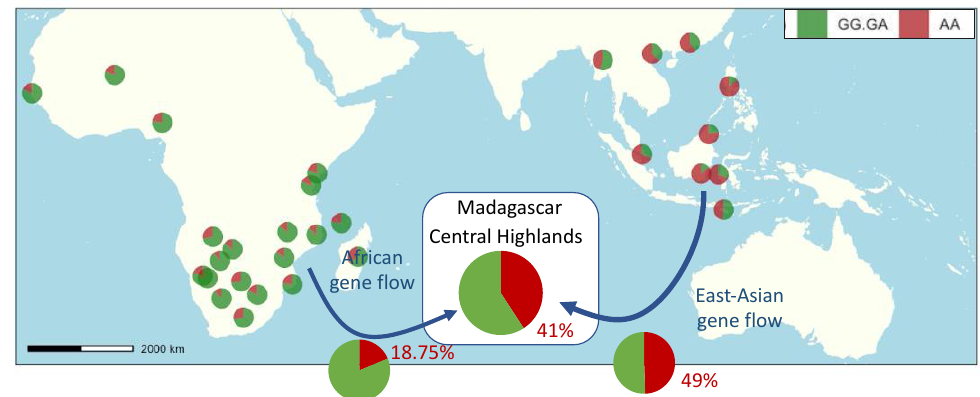
Figure 4. Distribution of “normosmic” (GG and GA) and “hyposmic” (AA) genotypes of r6591536 across populations from the western and eastern Indian ocean. Pie charts represent the proportion of genotypes across populations and are positioned according to the location of sampling [35,44,52–58]. The proportion of insensitive genotypes appears in red (Malagasy population and gene flows). The proportions in the gene flows are computed accordingly to the genotype frequency of Malagasy participants with the same origin for both chromosomes.